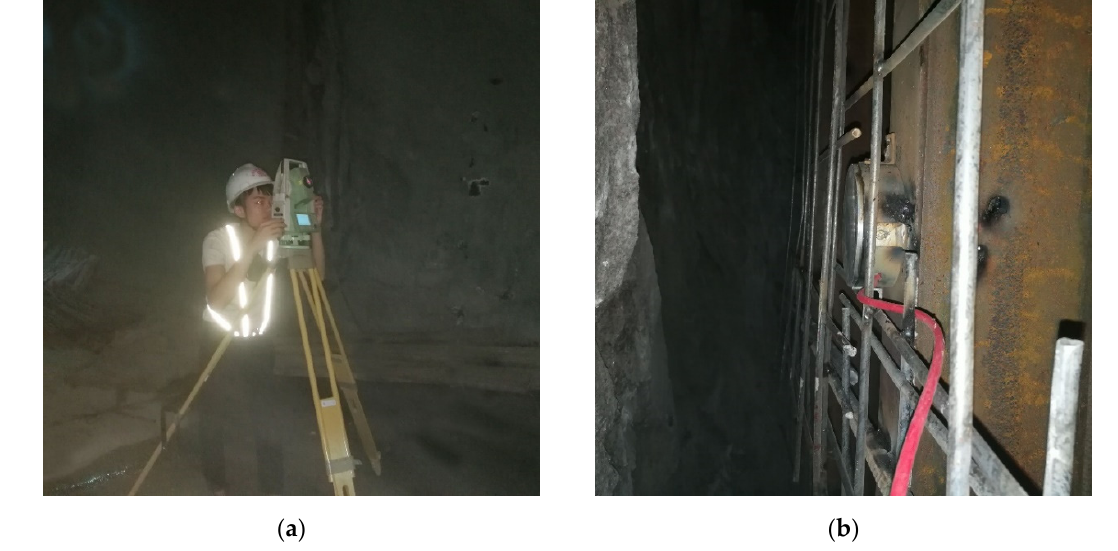
Figure 4. Installation of monitoring instrument: ( a ) Total station; ( b ) Double-membrane pressure cell.